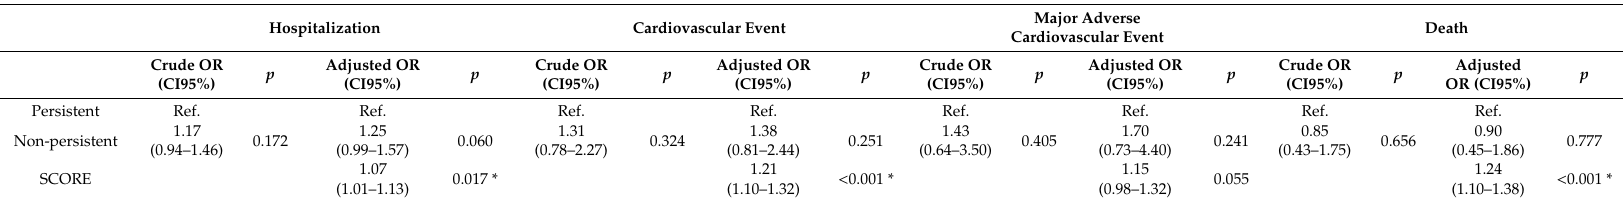
Table 3. Persistence with lipid-lowering treatment and risk of hospitalization, cardiovascular event, major adverse cardiovascular event (MACE), and death in men. Logistic regression analyses (crude and adjusted by SCORE